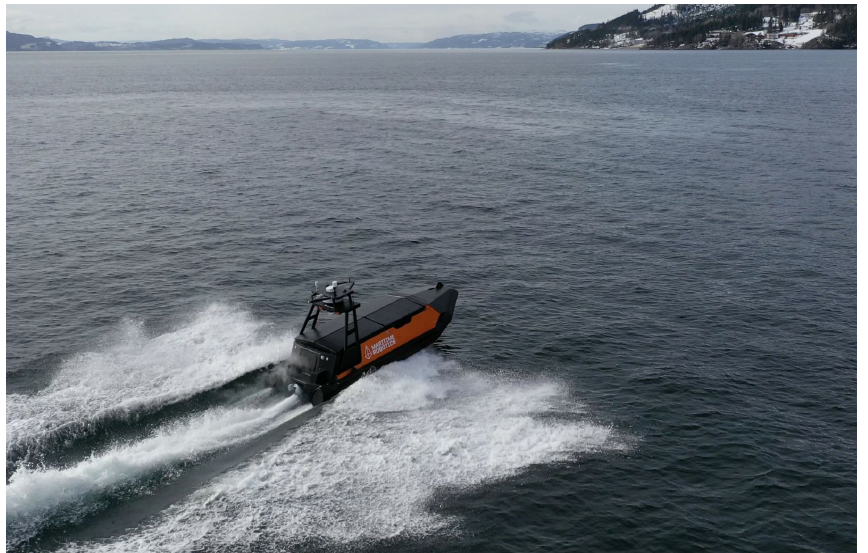
1.07 0.82 m and weight 65 kg) [3]. × ×